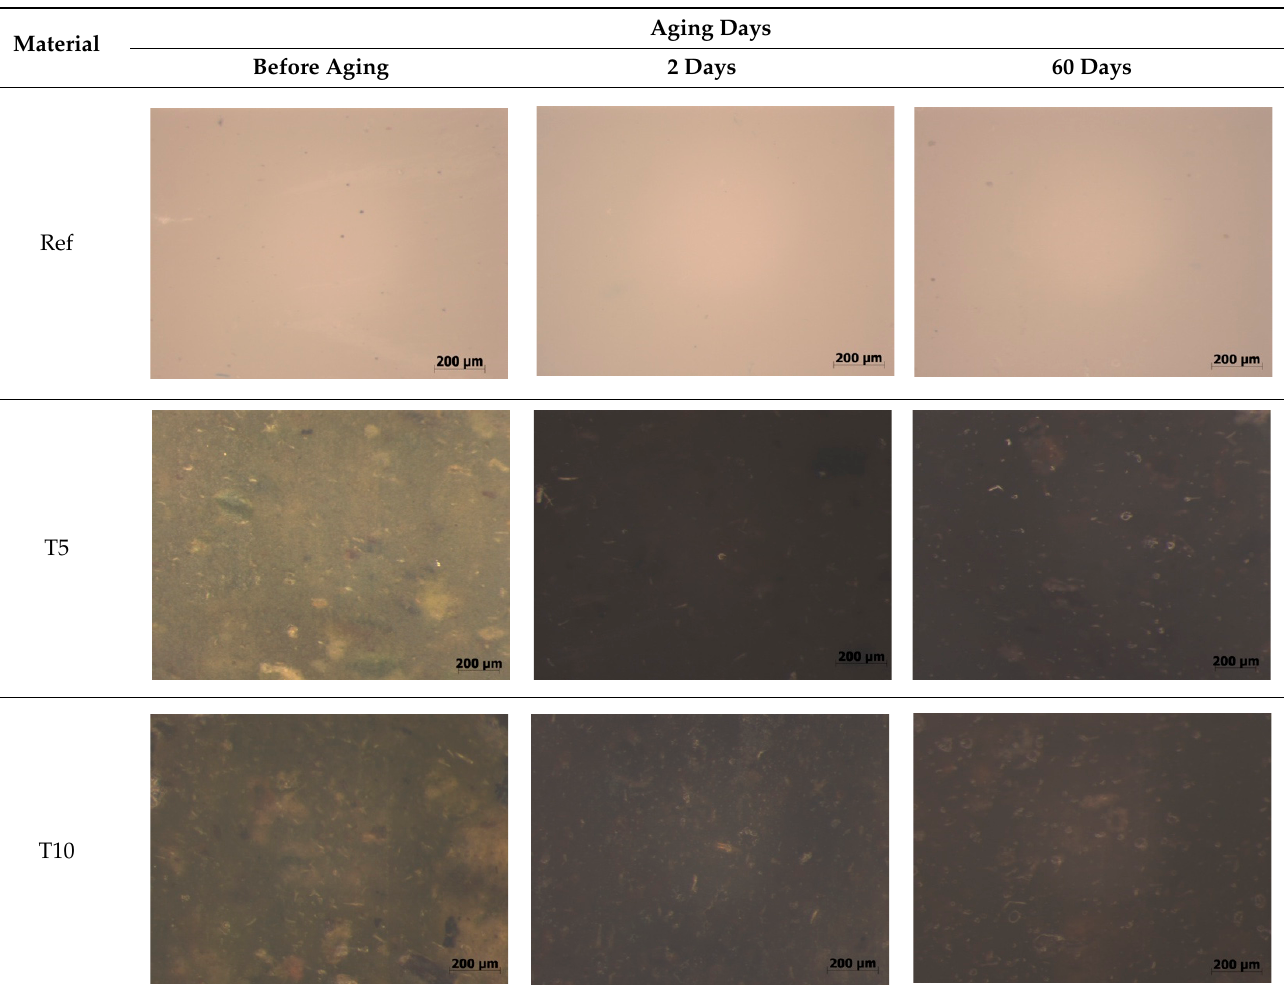
Table 4. Accelerated aging results.